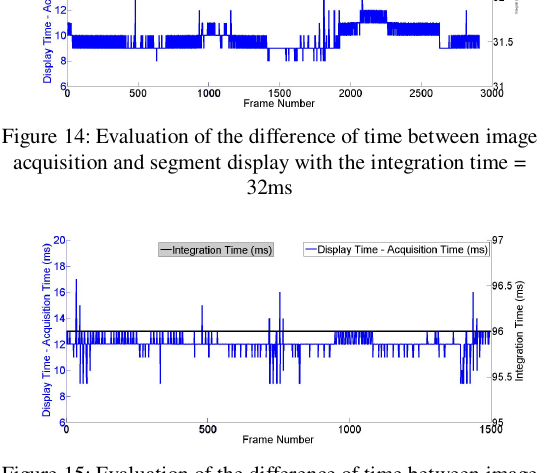
Figure 11: Evaluation of the tracking process with the integration time = 32ms